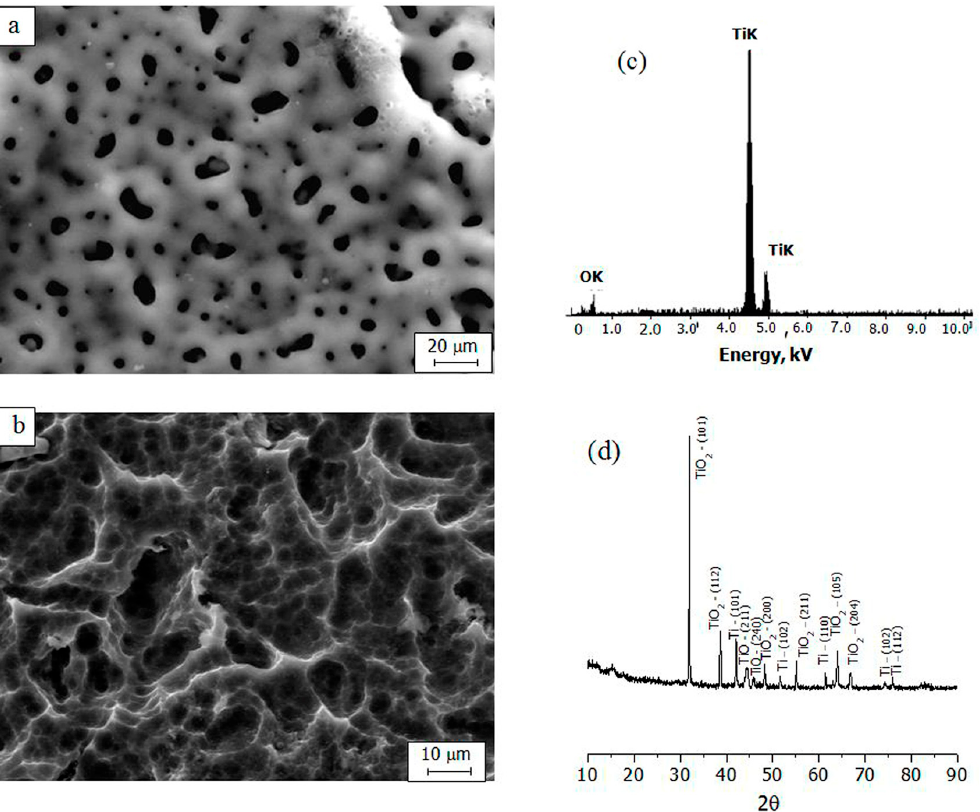
Figure 1. SEM-images of the titanium oxides (TiO 2 ) coating before sandblasting and subsequent acid etching ( a ), the Ti surface after acid etching ( b ), EDX spectrum ( c ) and X-ray diffraction pattern of the TiO 2 coating ( d ).